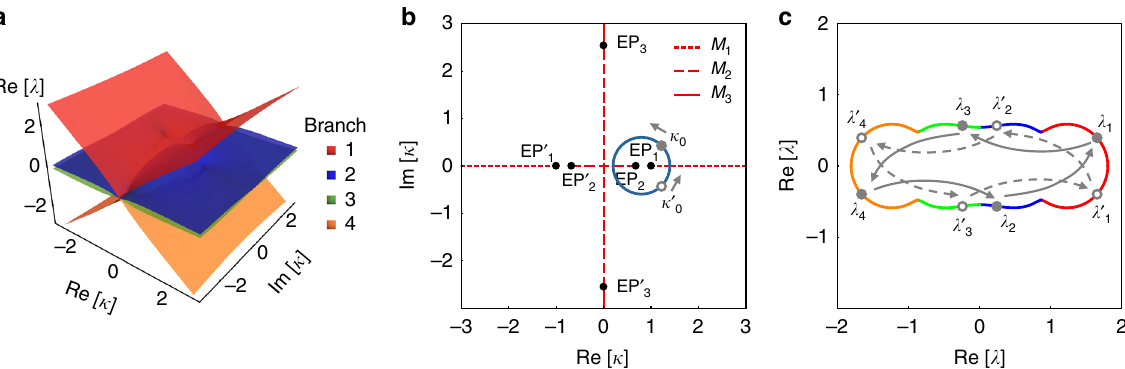
Fig. 4 Numerical illustration of our approach. a The branches of Riemann surface of the real part of eigenvalues of H in Eq. (6) are distinguished by different colors according to the magnitude of Re[ λ ]. b The exceptional points (EPs) (black dots) and their corresponding branch cuts (BCs) (red lines) are illustrated. Each BC is related with a permutation matrix M 1,2,3 in Eq. (7). One closed loop (blue line) encircles EP 1 and EP 2 counterclockwise (CCW), starting from κ 0 or κ ′ (the solid or hollow gray points) on the loop. Loops intersecting with BCs would lead to eigenvalues moving from one branch to 0 another, and result in the swap of eigenstates fi nally. c The stroboscopic evolution of complex eigenvalues are plotted as a parametric function of κ when it moves along the loop CCW. The eigenvalues at the starting point are labeled as gray points (solid or hollow) on their trajectory. The colors in the eigenvalue trajectory represent which branch the eigenvalues are located at instantaneously. The joints of two colors are where the κ crosses the BCs. The gray points (solid or hollow) and arrows illustrate the evolution of eigenvalues for starting from κ 0 or κ ′ 0 , and therefore the evolution of eigenstates is { s 1 , s s s → { s s s s → { s s s s 2 , 3 , 4 } 3 , 1 , 4 , 2 } and 2 , 4 , 1 , 3 },